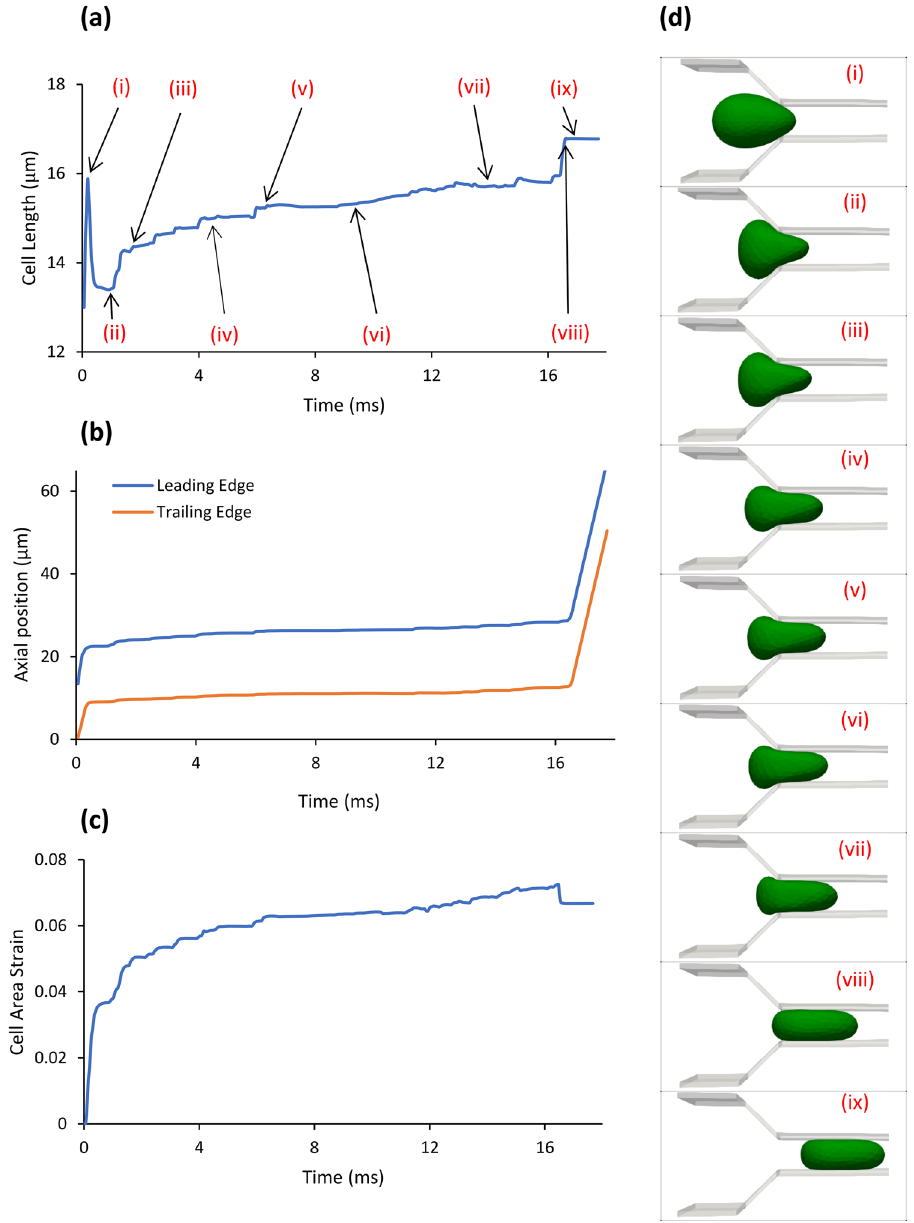
Figure 3. Deformation and motion of a lung cancer (H1975) in a microfluidic channel with flow rate of 22.8 µL/h calculated using the validated model. ( a ) evolution of the cell length as the cancer cell advanced in the microchannel, ( b ) motion of the cell in the microchannel represented by the trajectories of its leading and trailing edges, ( c ) evolution of the area strain of the cell (change in the cell area relative to its undeformed shape divided by its undeformed initial area) as the cell advanced in the microchannel, and ( d ) snapshots of the 3-D model of cell progression in the microchannel at nine instances. The instances shown in ( d ) are indicated by arrows in the evolution of cell length in panel ( a ). The cell underwent a rather sudden elongation in Step i that was accompanied by a jump in the area strain as well. The cell length then quickly decreased upon start of squeezing of the cell to the constriction between Steps i and ii but the area strain continued to grow as the cell expanded in the direction normal to the view provided in panel ( d ). Between Steps ii and viii, the cell continued to deform as it is evident from panels ( a , c , d ) while it stayed almost at the same position as panel ( b ) shows. After complete entry of the cell in the constriction, the cell transited in the constriction in Step ix that was much shorter than the entry time as the sloped trajectory lines of panel ( b ) near the end of the time